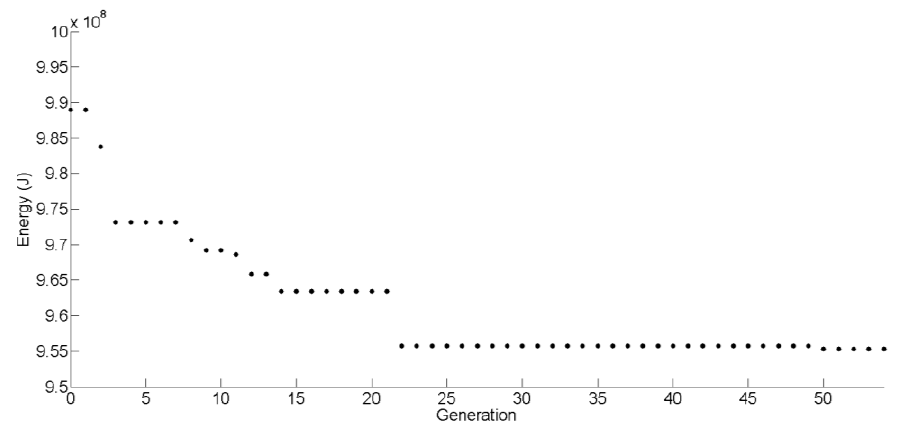
Figure 12. The results of the genetic